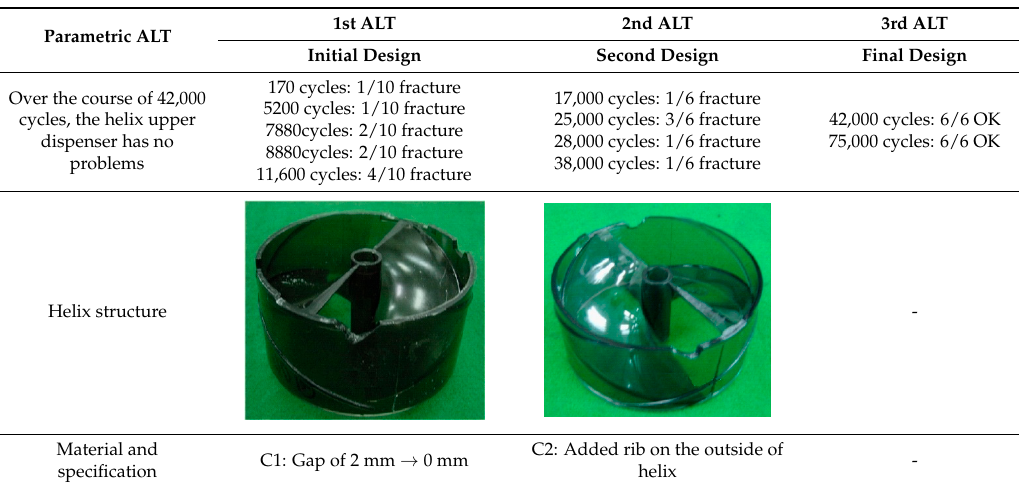
Figure 11. Redesigned helix upper dispenser. ( a ) Old design; ( b ) New design.